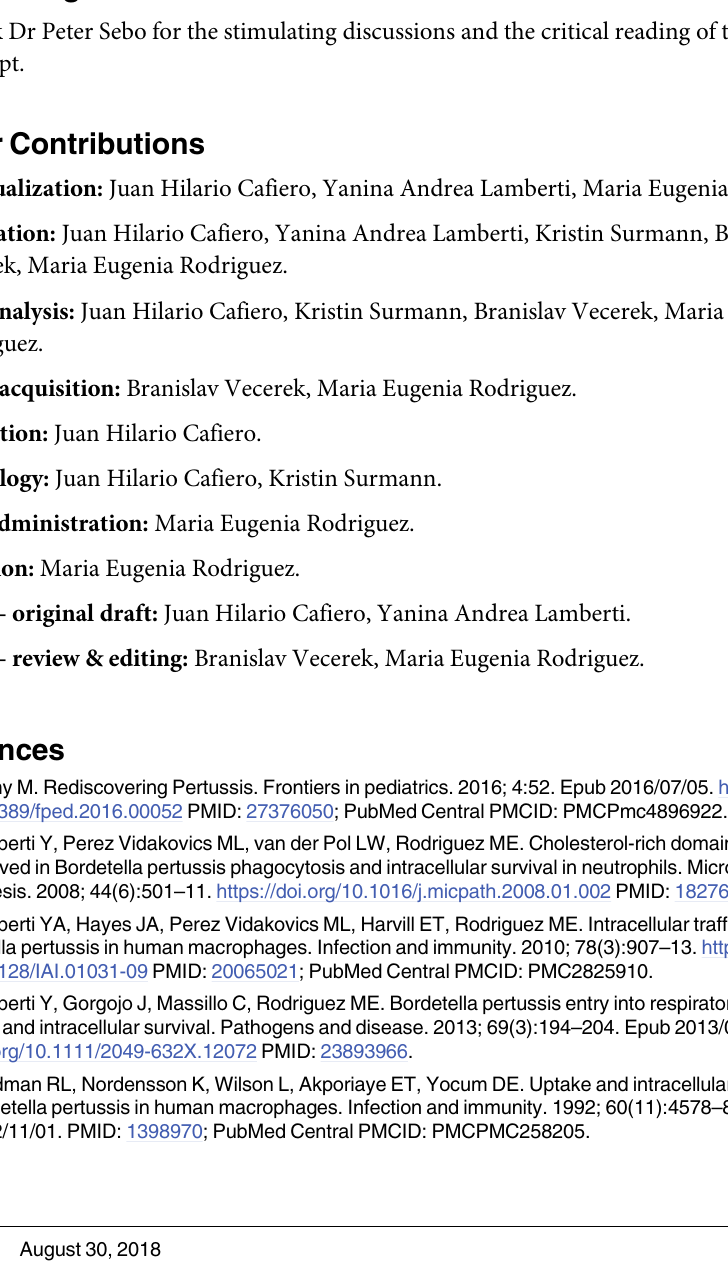
S1 Table. Transition list for final data acquisition by SRM. The parent proteins, the peptide sequences, the mass/charge ratios of the precursor and product ions, and the collision energies applied are listed. S1 Data. Raw data of Fig